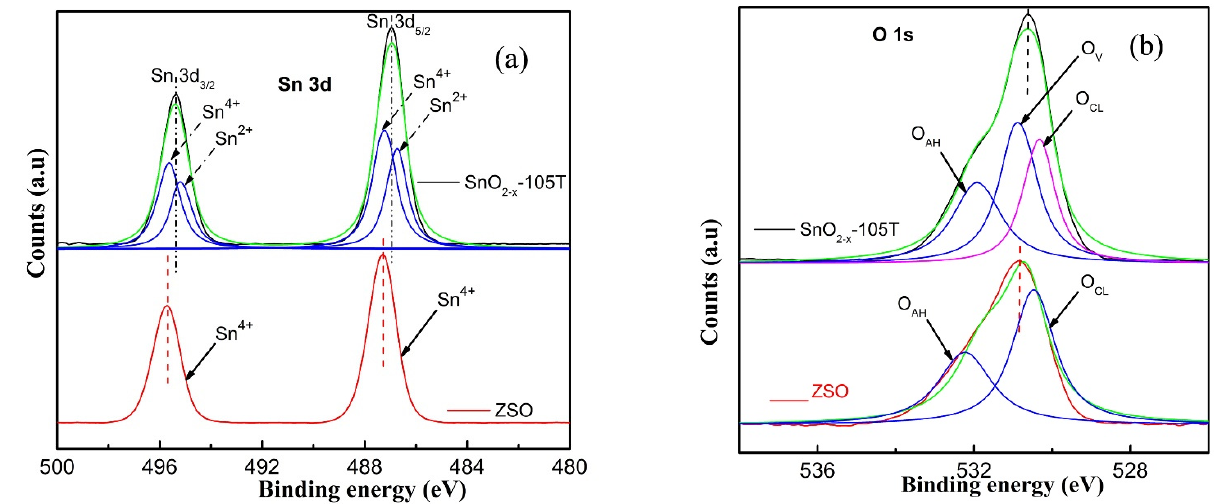
Figure 3. High resolution XPS spectra of the ZSO and SnO 2 − x -105T sample, ( a ) Sn 3d; ( b ) O 1s.